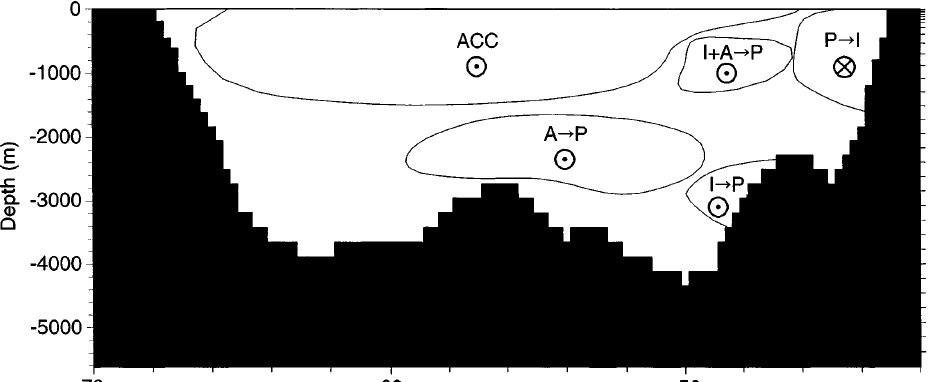
Fig. 11. A schematic meridional section along 146 (cid:14) E between Antarctica at 69 (cid:14) S and Australia at 42 (cid:14) S. The arrowhead and arrowtail symbols indicate water flowing eastwards and